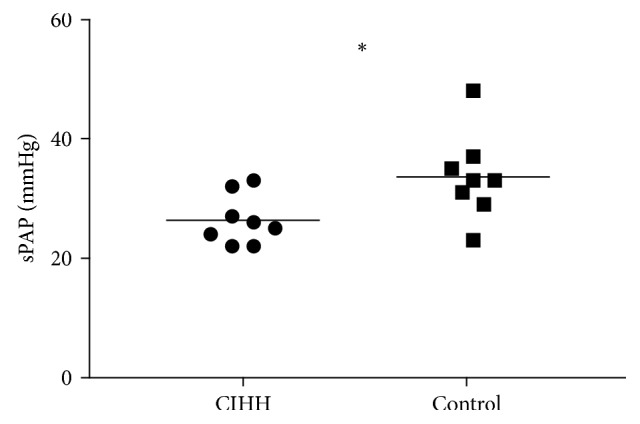
sPAP under exertion (75 W) at high altitude. sPAP was significantly higher in CIHH than in controls. CIHH: chronic intermittent hypobaric hypoxia. ∗By t-test.